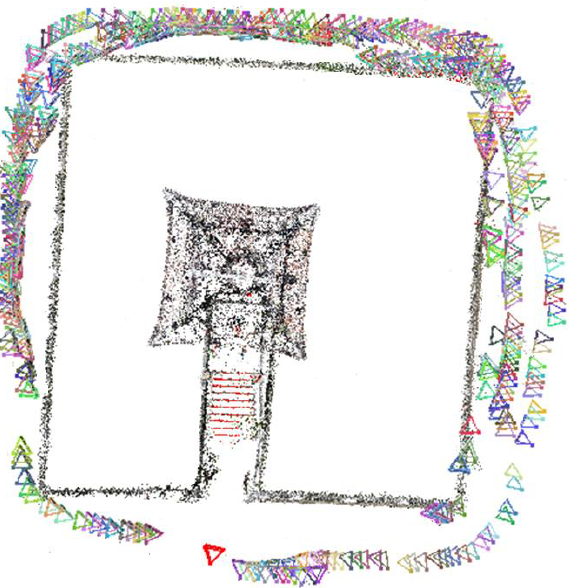
Figure 3. Figure placement and numbering from VisualSFM